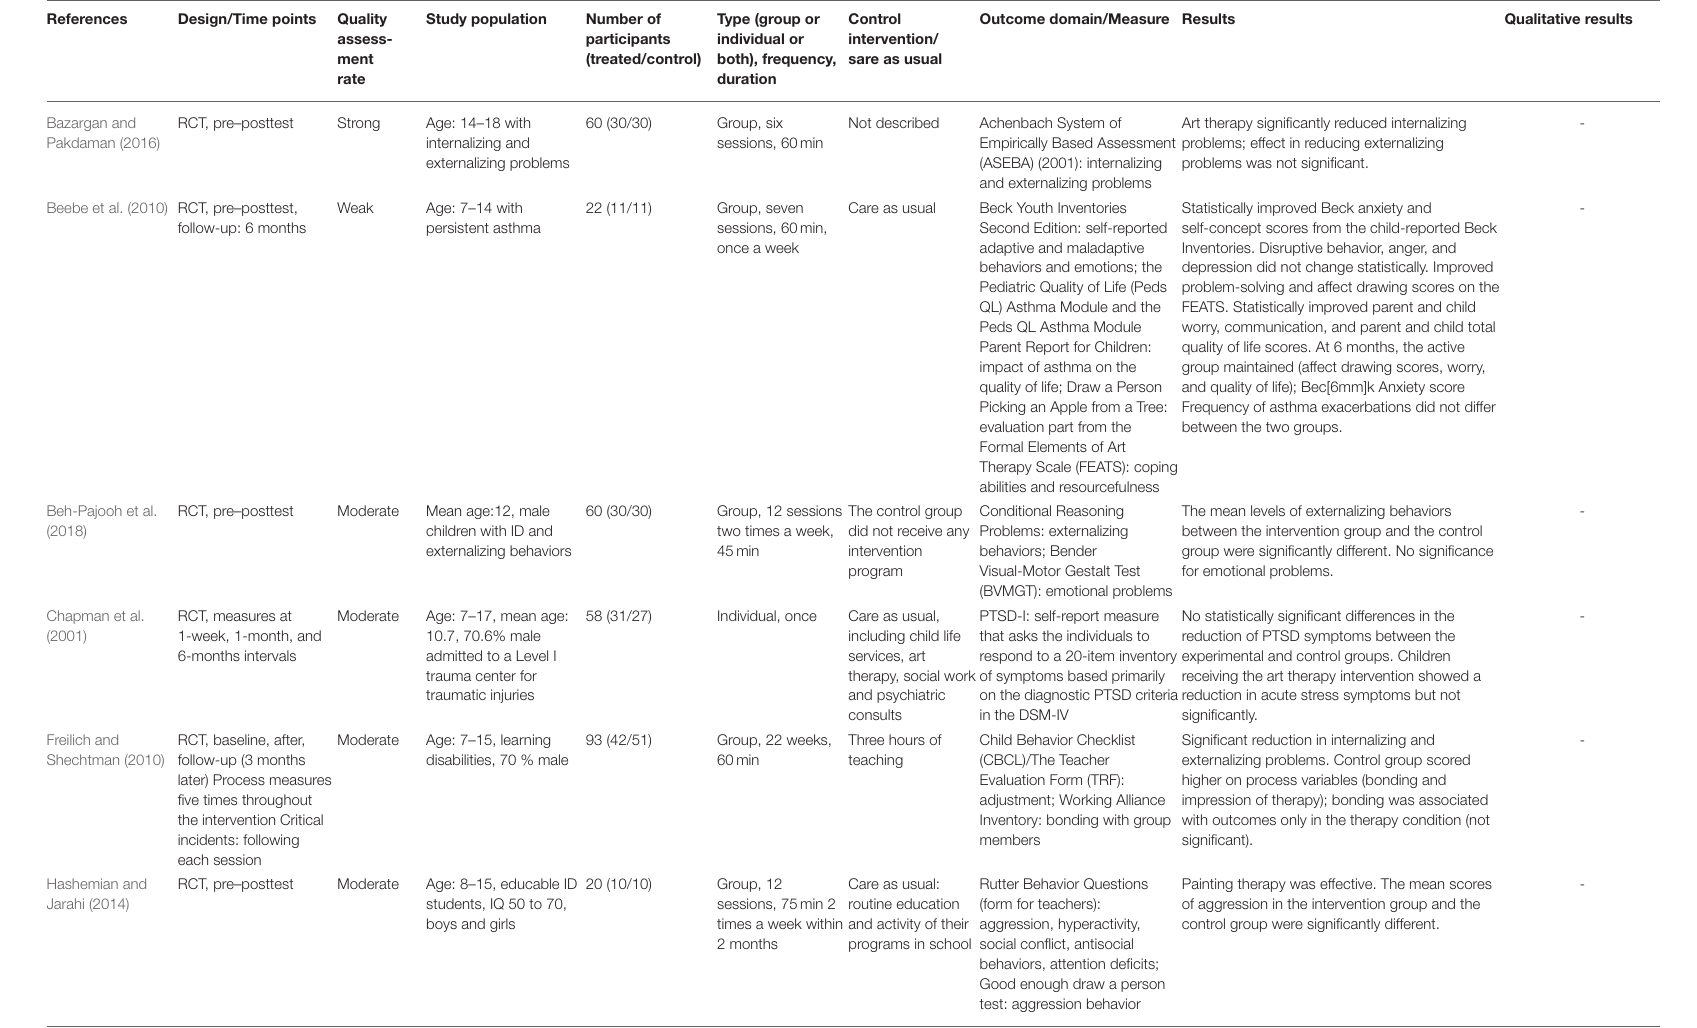
TABLE 1 | Study characteristics/outcome.